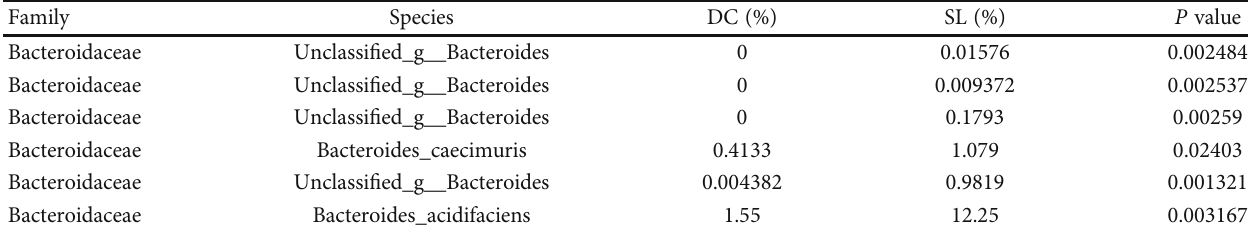
Table 3: The relative abundance of 6 species increased by SL